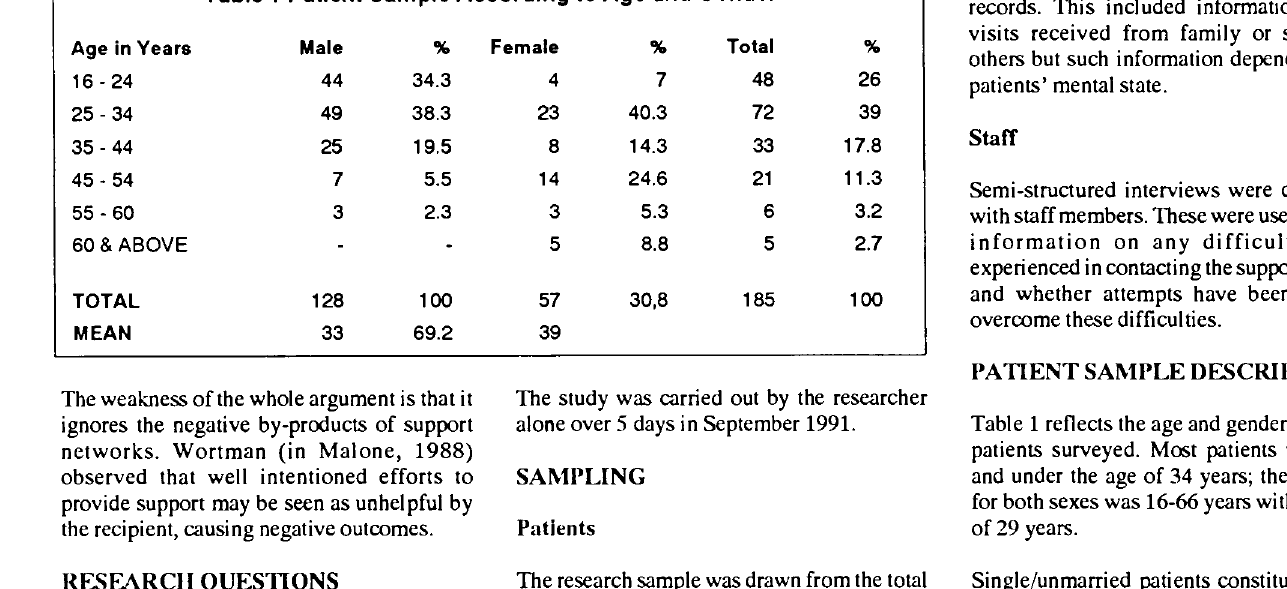
Table 2: Addresses used by Patients (n=185)